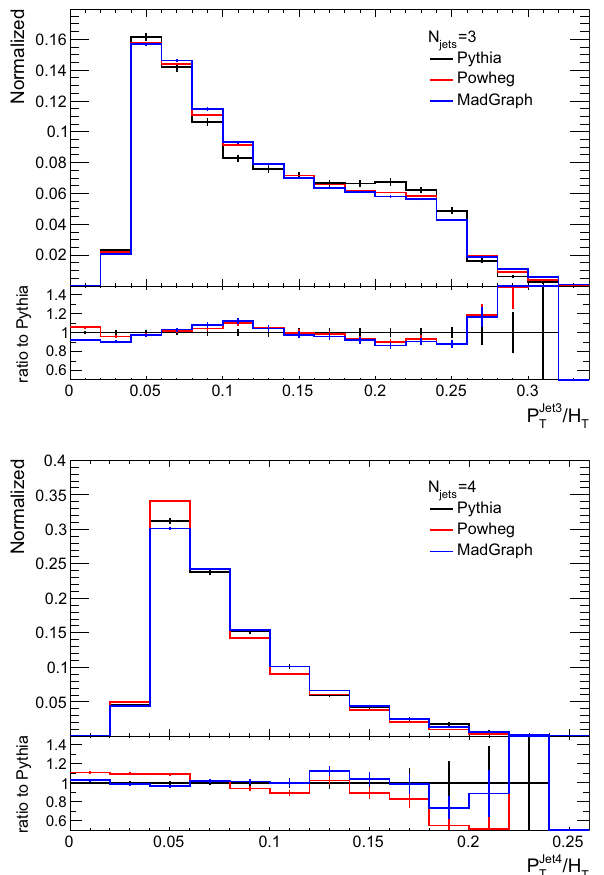
Fig. 5 Angular distribution of third jet relative to the transverse thrust axis (see Eq. 2) in 3-jet events (top) and by the fourth jet in 4-jet events ( 4 ) (bottom). All entries are for events satisfying H T > 1 TeV T ) in 4-jet events H T Because of momentum conservation and the simplistic assumption that the PS is carried out for each of the